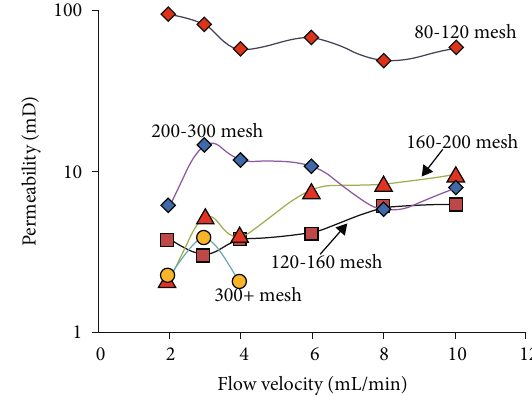
Figure 5: E ff ect of fl ow velocity and coal fi nes size on permeability.